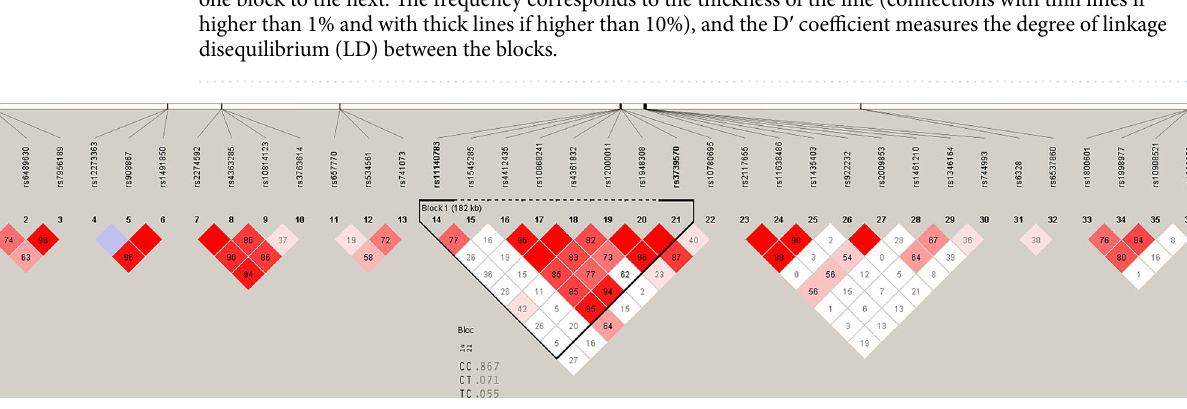
Figure 4. Haplotype block map of block 7 (defined